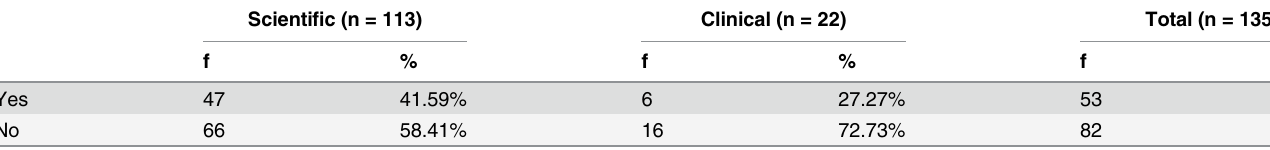
Table 7. Responses to “ Have you ever uploaded your data to a public repository? ”